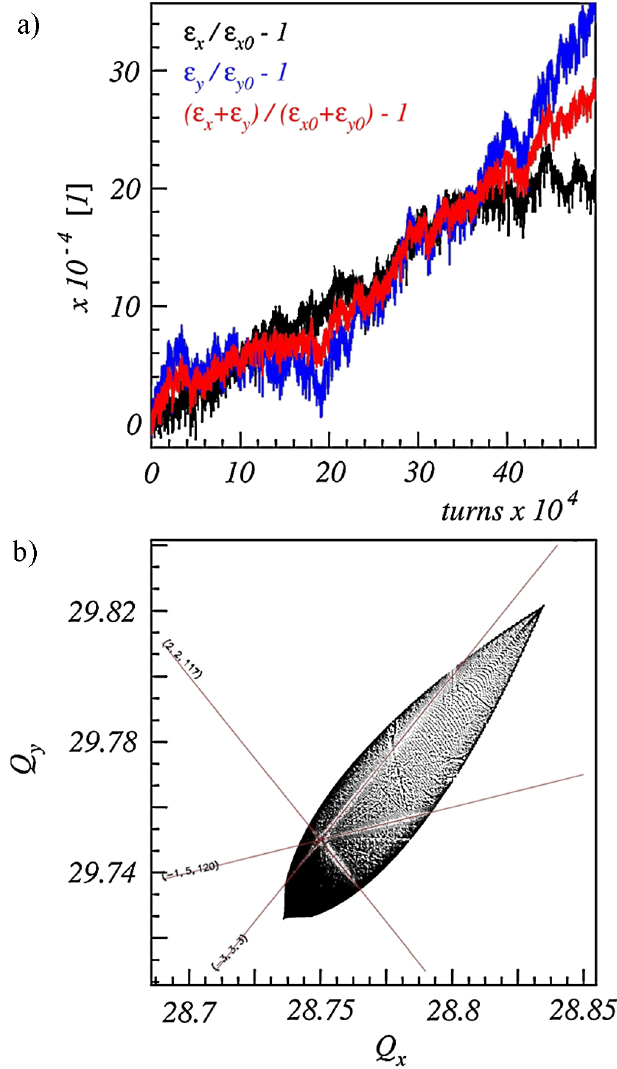
FIG. 14. (Color) LHC beam emittance evolution versus time for ¼ 0 : 1 (top); frequency map for LHC for a beam with (cid:1) Q ec ¼ 0 : 18 (cid:1) Q ec